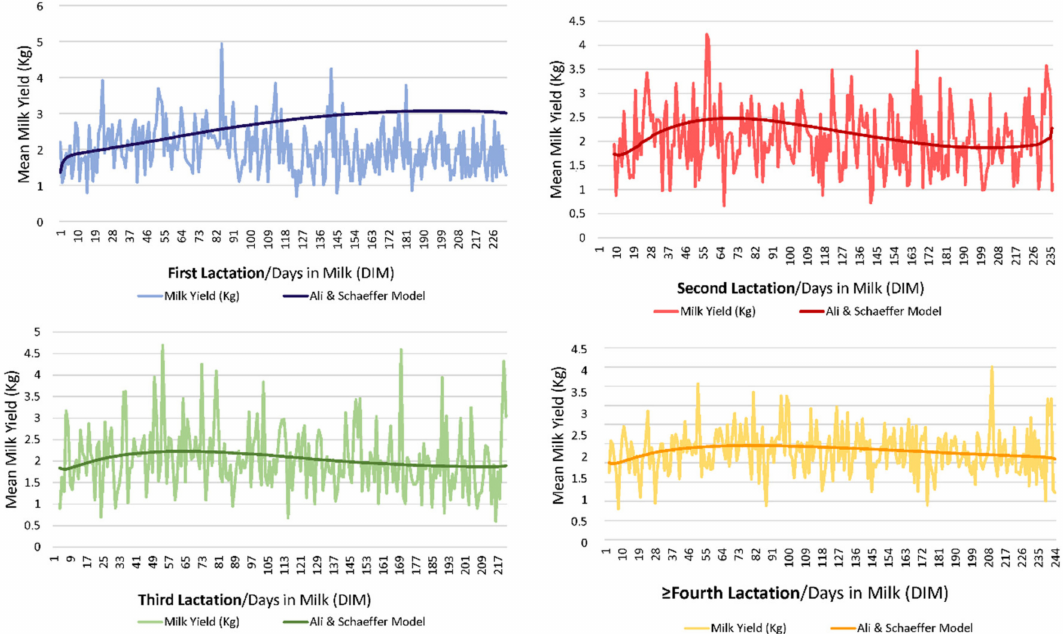
Figure 1. Graphical representation of the evolution of milk yield (Kg) through lactation from first, second, third and fourth or later lactations in Murciano-Granadina